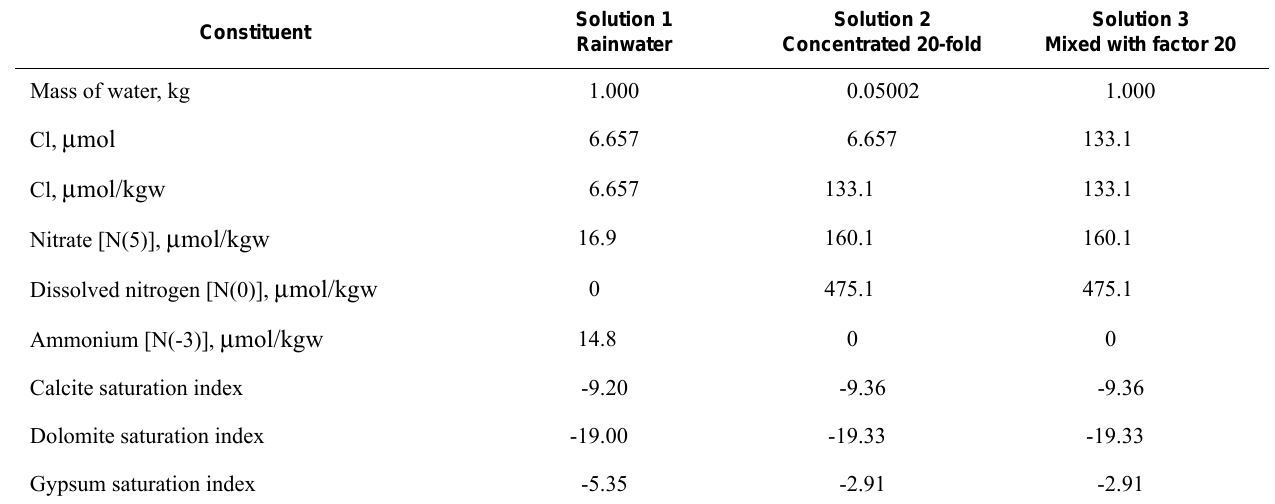
Table 18. Selected results for example